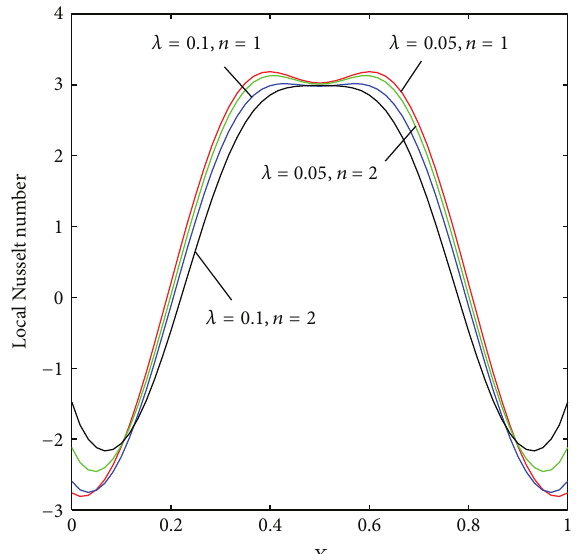
Figure 5: Local Nusselt number along heated bottom wall for 𝜆 = 0.05, 0.1 and 𝑛 = 1, 2